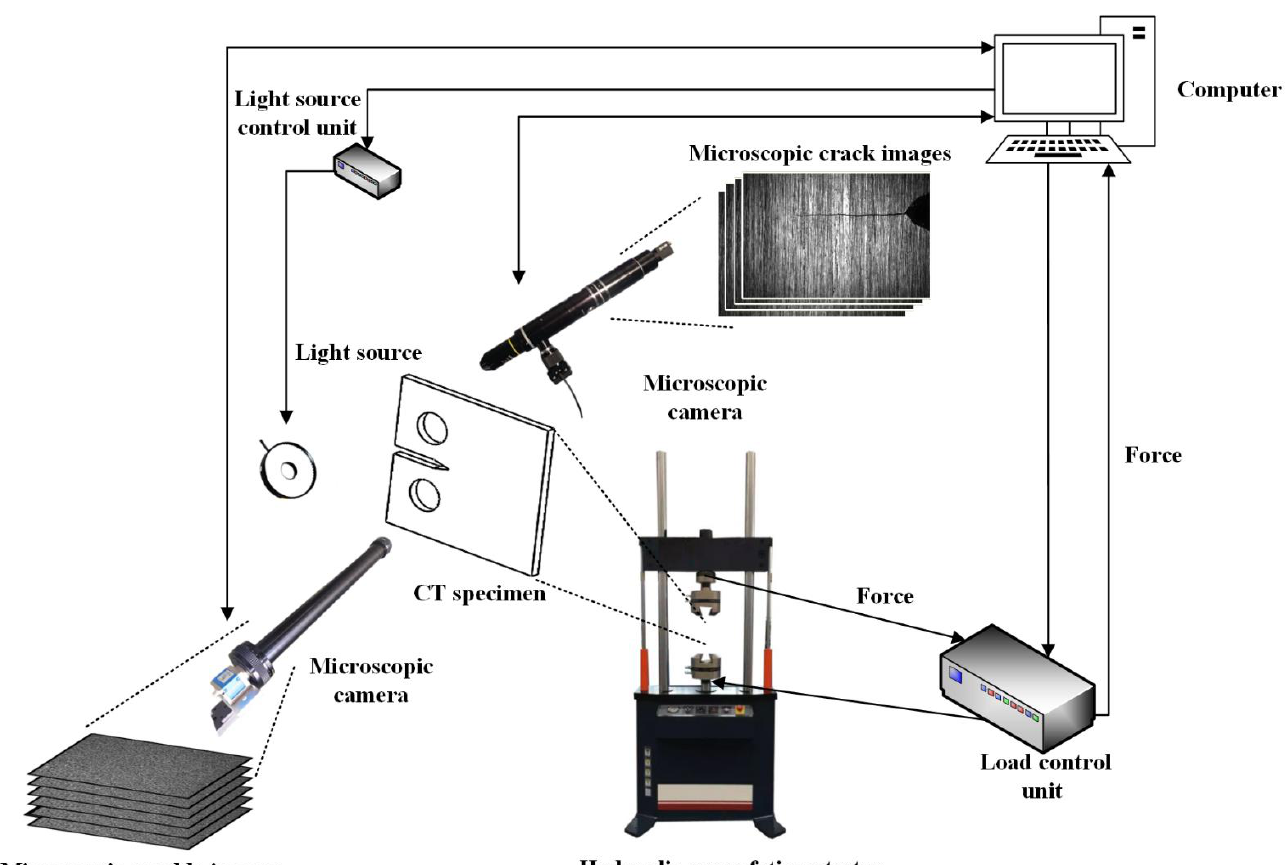
Figure 3. Schematic representation of the system components. Table 2. Main hardware